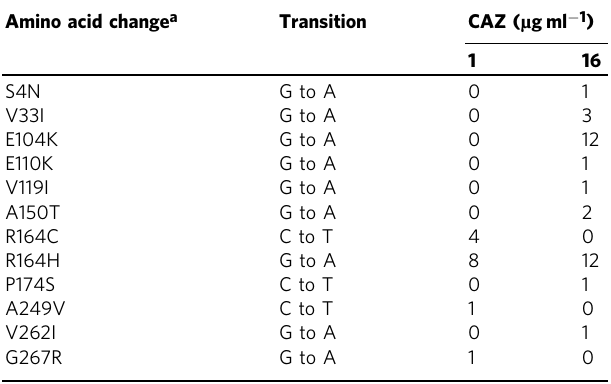
Table 1 TEM-1 mutations in ceftazidime resistant (CAZ R ) clones.